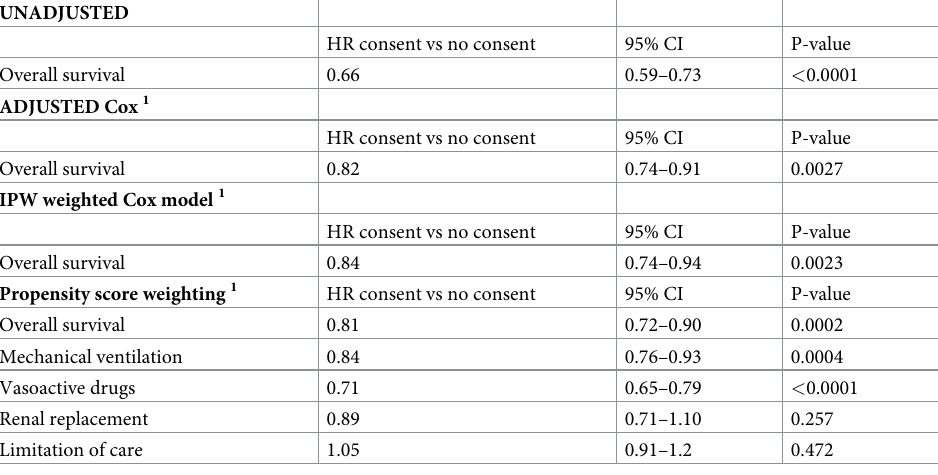
Table 4. Results from the Cox analysis and propensity score weighting in the consent versus non-consent groups.